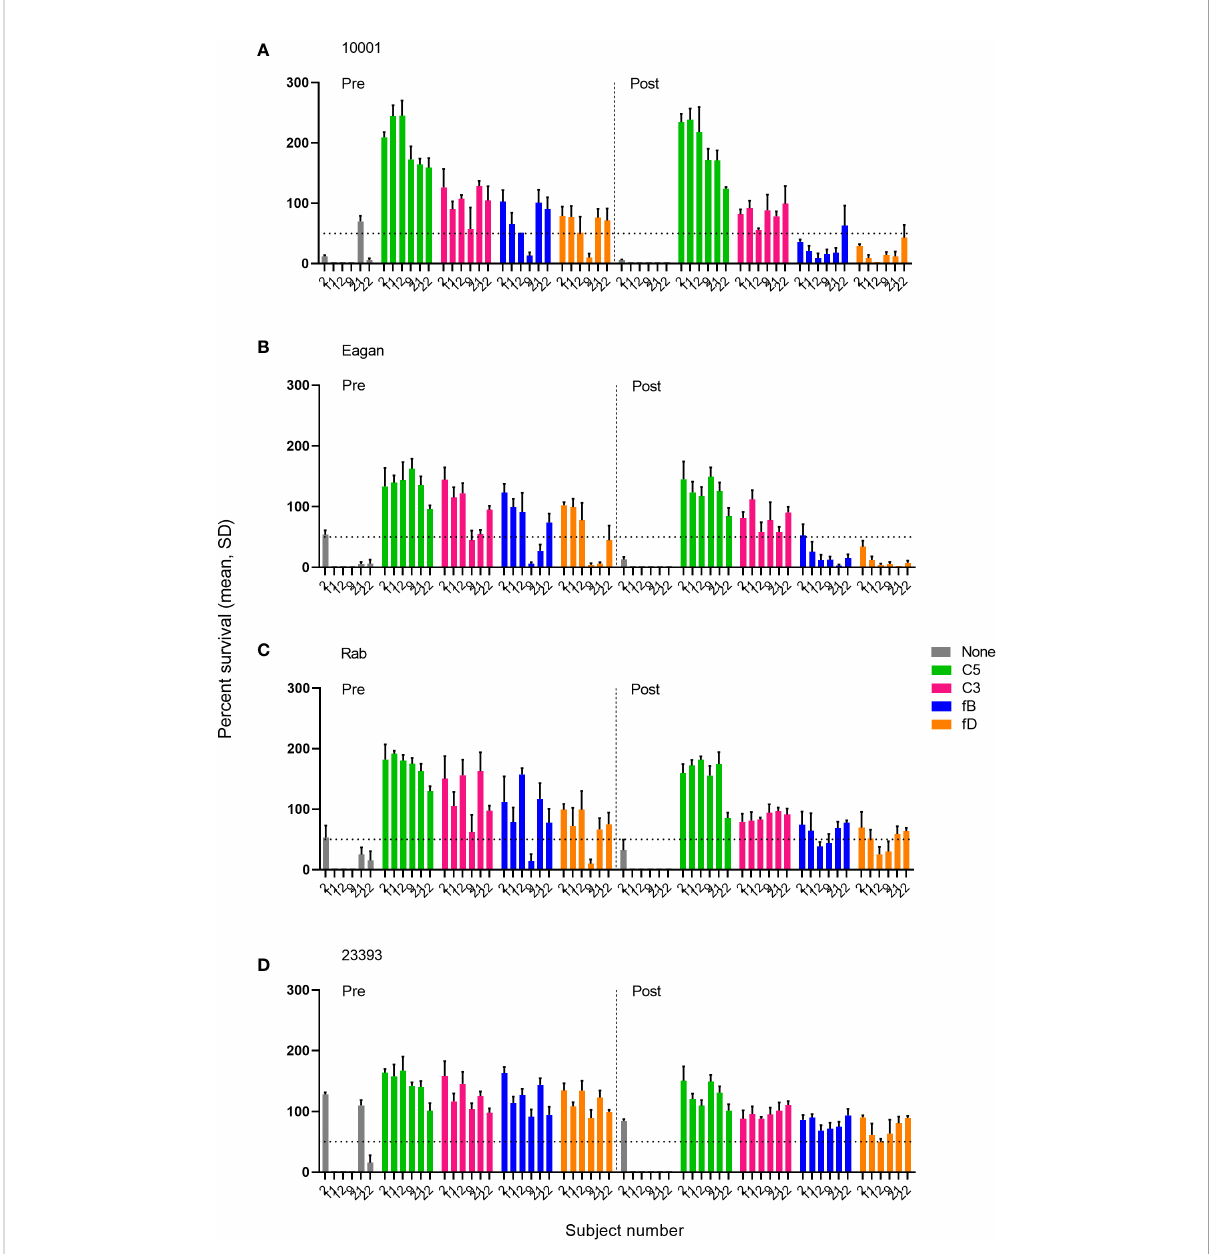
FIGURE 3 Impact of complement inhibitors targeting the terminal pathway (C5), C3 and the AP (fB, fD) on the survival of Hib isolates (A – D) in sera taken prior to vaccination (Pre) or 2 weeks after vaccination with ActHIB (Post). Sera were diluted 1:5 and assayed with the preserved internal complement. Data shown in the graphs are with the highest inhibitor concentration tested (25 µM for the fB inhibitor iptacopan and the fD inhibitor CMS487, 100 µg/mL for the C3 inhibitor CP-40 and the anti-C5 mAb tesidolumab). The horizontal dotted line represents 50% survival of bacteria after 60 minutes incubation, as compared to control wells at time 0. Data for each inhibitor are triplicate technical replicates. SD, standard